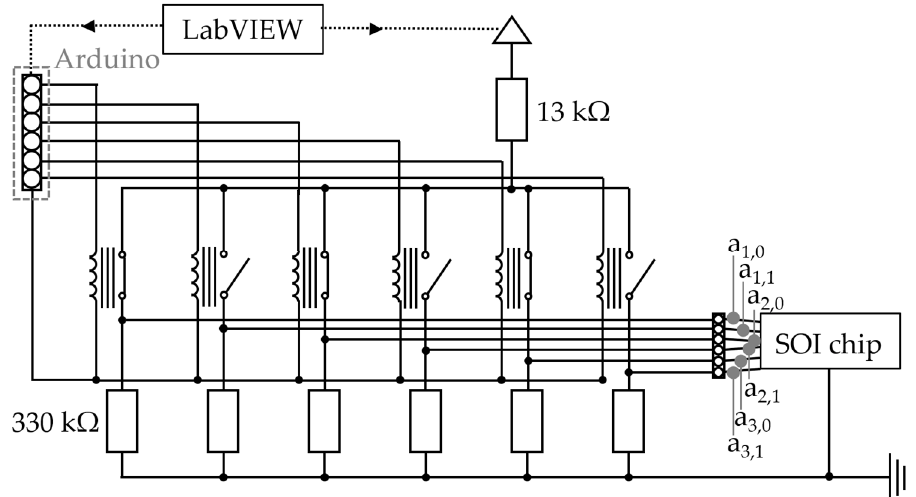
Figure 8. A LabVIEW program controls the voltage source, with an Arduino activating the relays in an arbitrary order and as a function of time. The relays are connected to the actuators of the SOI chip. Here, the relays are exemplarily activated to drive the 000